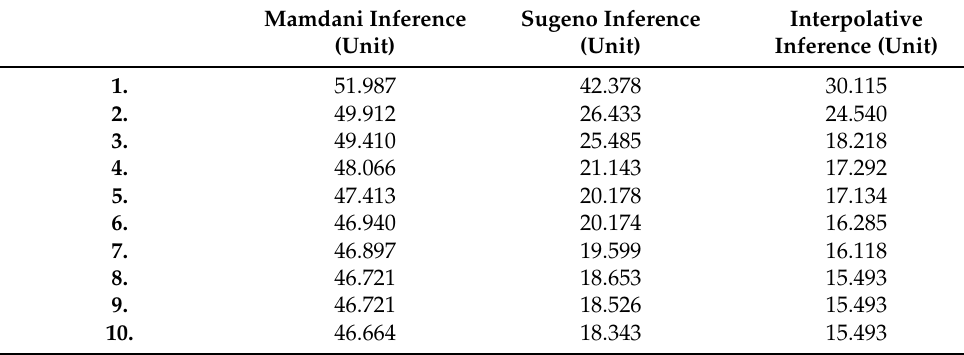
Table 6. Comparison of fuzzy control models by cost